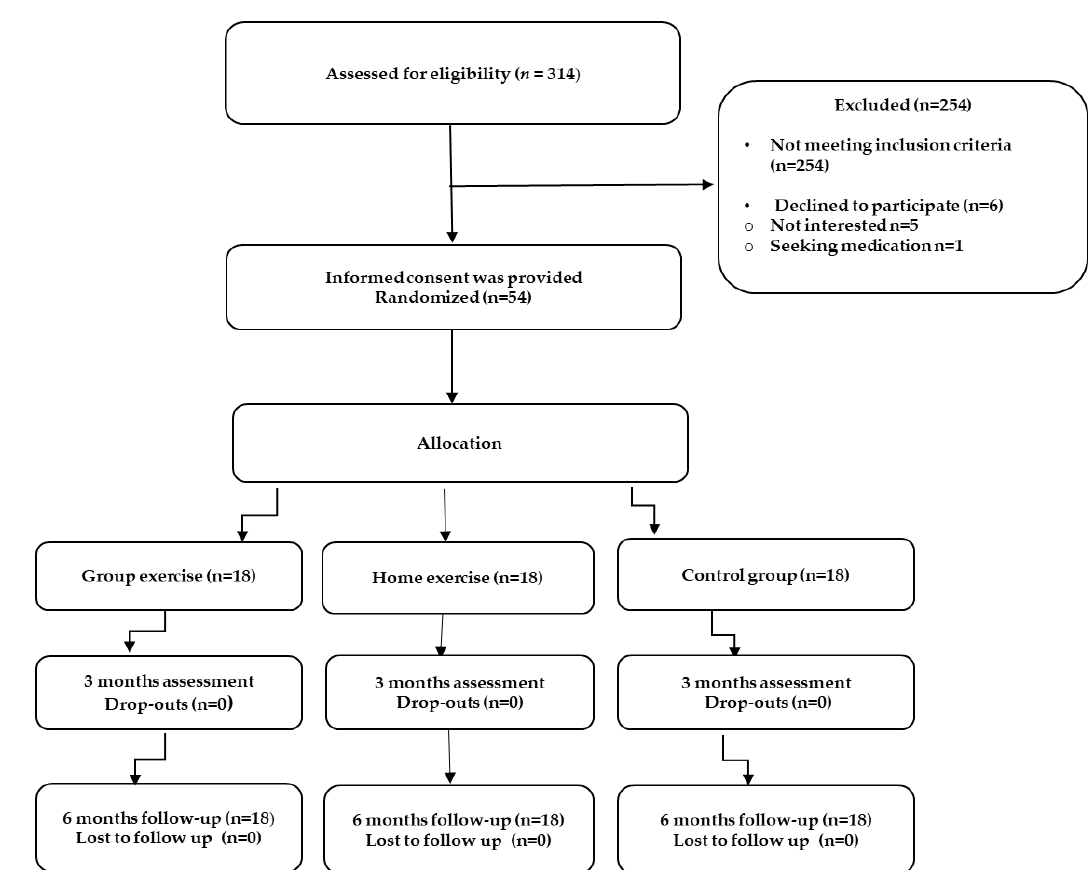
Figure A1. CONSORT flow diagram of patient selection and allocation.